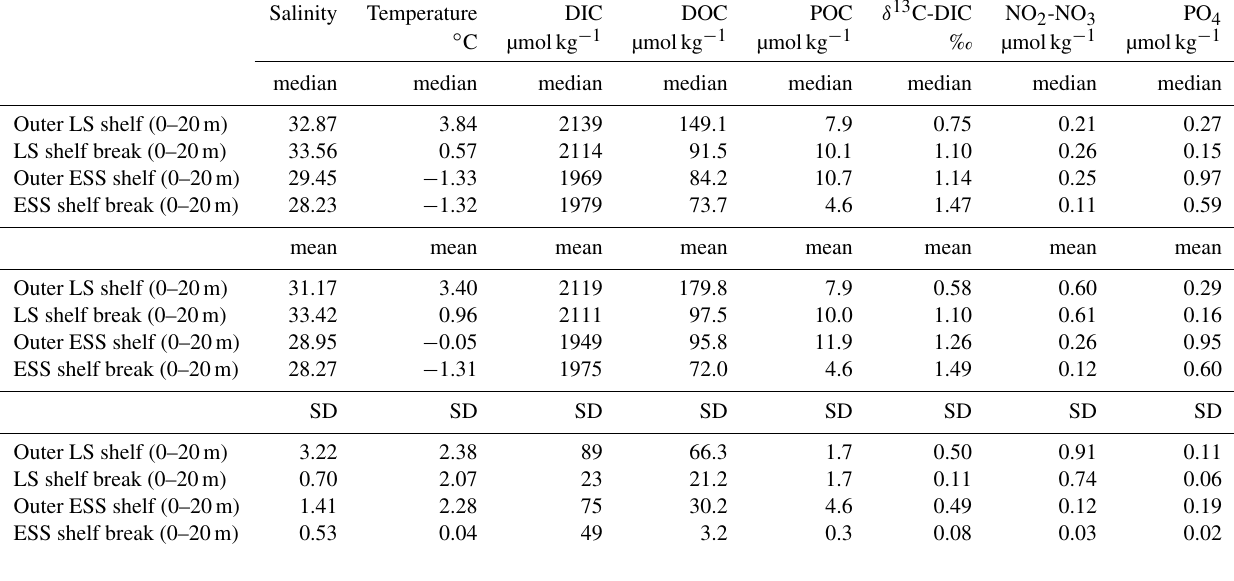
Table 2. Surface water (0–20m) chemical and physical properties during the SWERUS-C3 expedition ∗